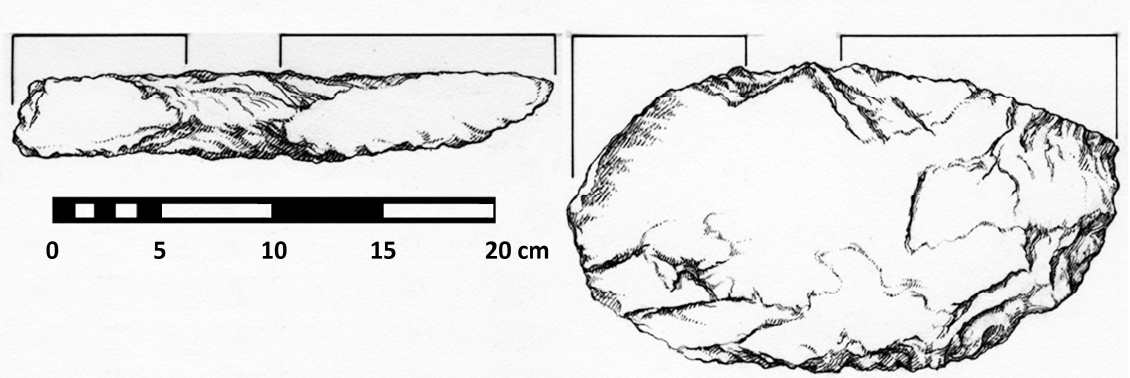
Figure 2. An Elliptical-shaped tool. Specimen 17, (a) flat surfaces (hand holds) interrupted by a retouched portion of the upper edge, and (b) face of the tool (working edge down). (Drawing by Narda Lebo.) As a group, the 16 specimens have a mean length of 200.4 mm (range = 106-293 mm),